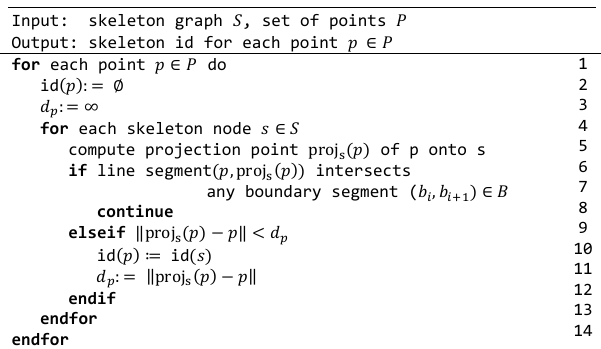
Figure 8c and 8d demonstrate the result of this